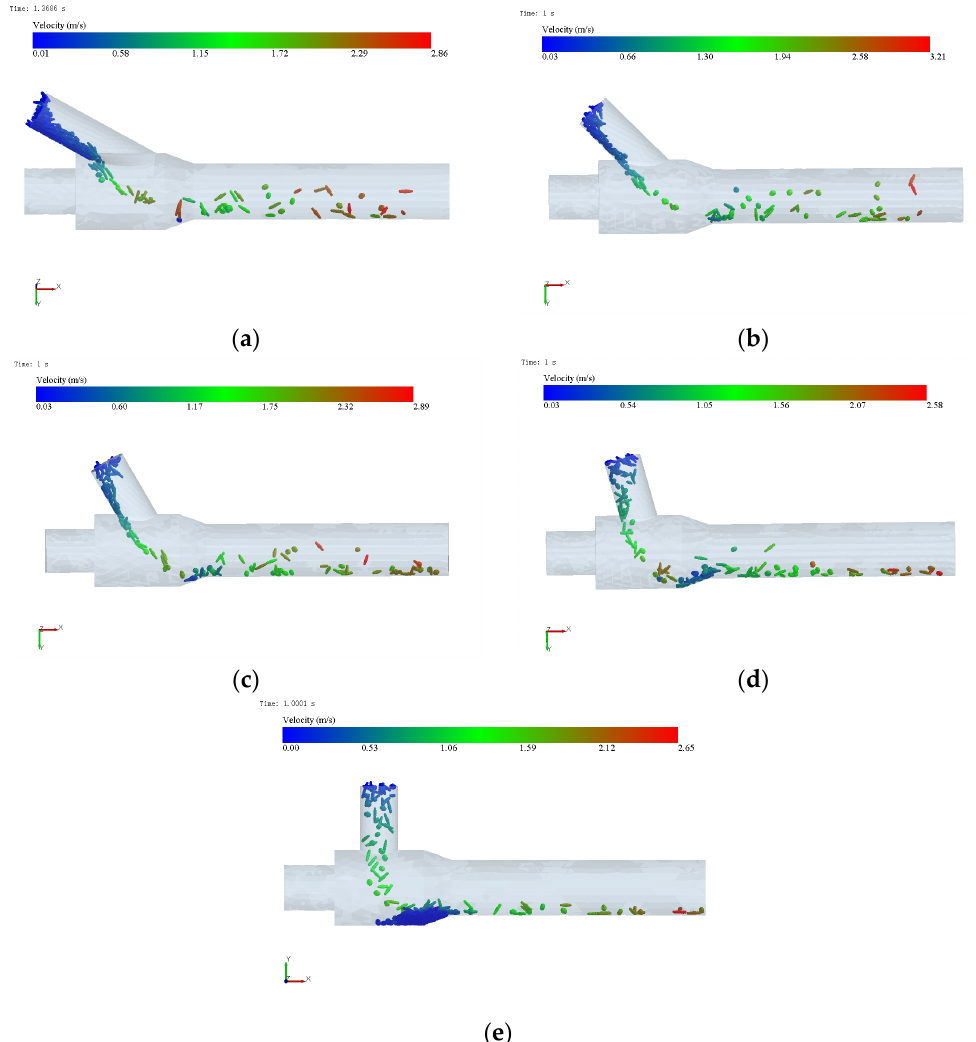
Figure 7. Five motion states in venturi tube with di ff erent implantation angles: ( a ) 30° ( b ) 45°; ( c ) 60° ( d ) 75°; ( e ) 90°.